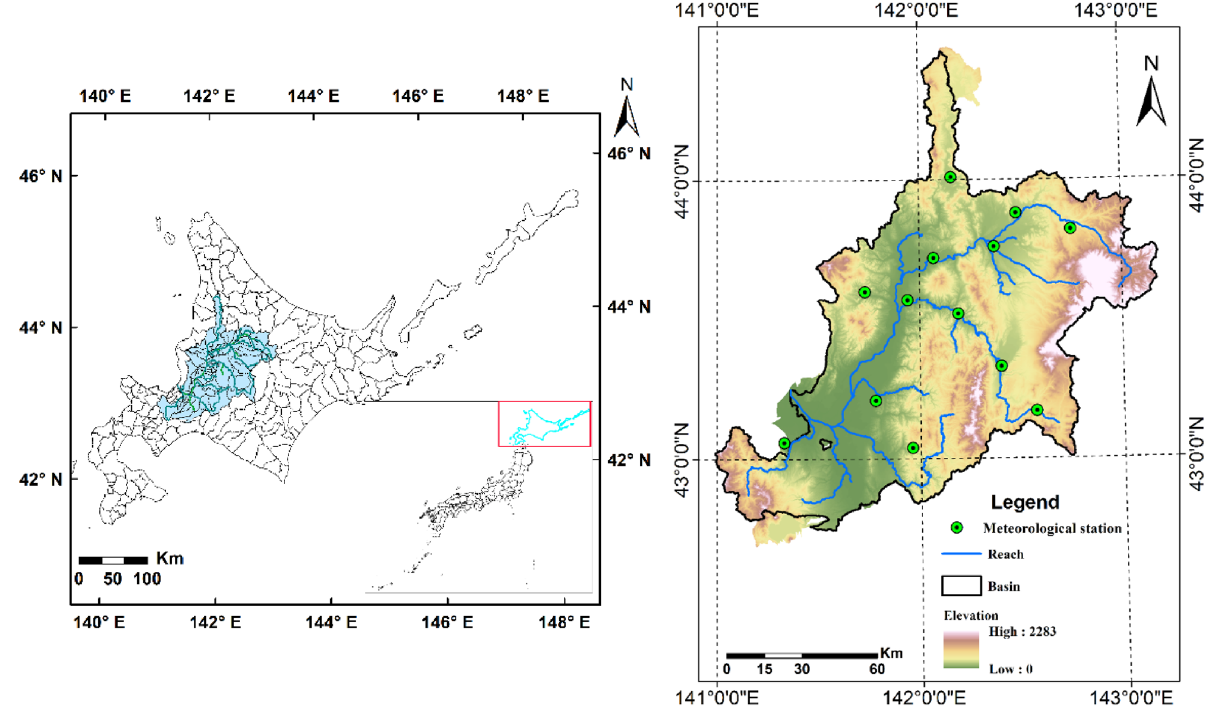
Figure 1. Locations of the Ishikari River basin (IRB) and its meteorological stations. Note: This figure was generated by ArcMap 10.2 (https:// suppo rt. esri. com/ en/ produ cts/ deskt op/ arcgis- deskt op/ arcmap/ 10-2-2). Shapefiles are available from the Japanese Geographical Survey Institute (JGSI, http:// nlftp. mlit. go. jp).